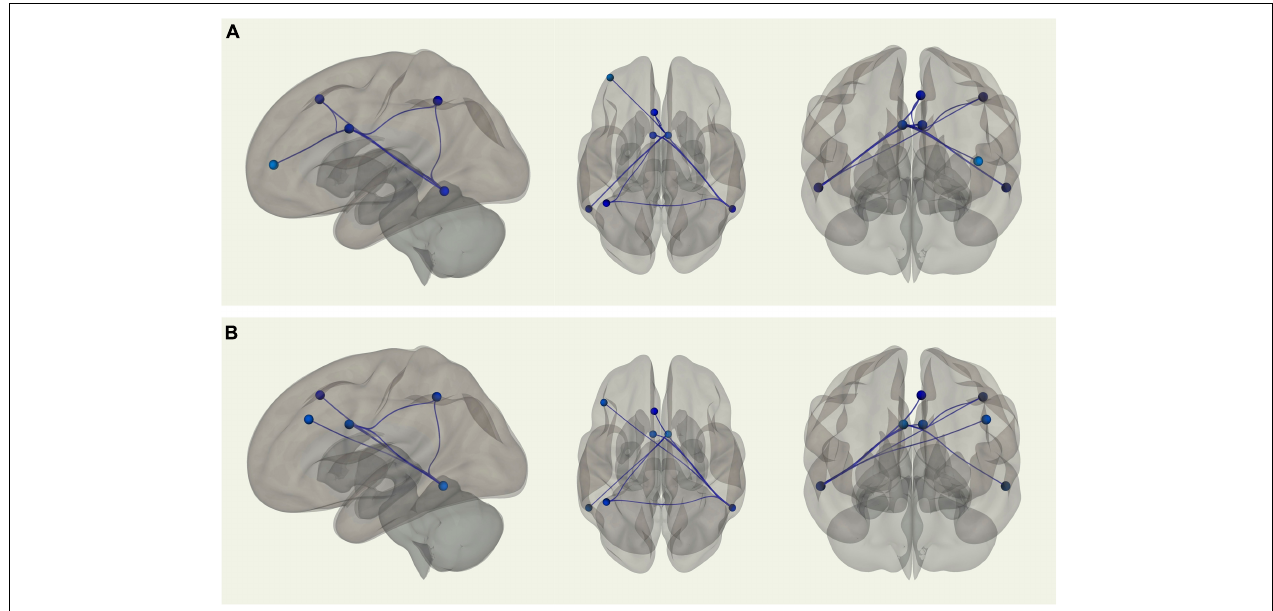
FIGURE 2 | (A) Sagittal, transverse, and coronal images displaying functional connections between ROIs within the FPCN that were significantly different in terms of strength between young and older adults and passed correction for false discovery rate; blue connections indicate stronger functional connectivity among young adults, while red connections indicate stronger functional connectivity among older adults. Note that in this analysis there were no connections that were stronger in older adults. (B) Sagittal, transverse, and coronal images displaying functional connections between ROIs within the FPCN that were significantly different in terms of strength between young and older adults when controlling for VO 2 peak and passed correction for false discovery rate; blue connections indicate stronger functional connectivity among young adults, while red connections indicate stronger functional connectivity among older adults. Note that in this analysis there were no connections that were stronger in older